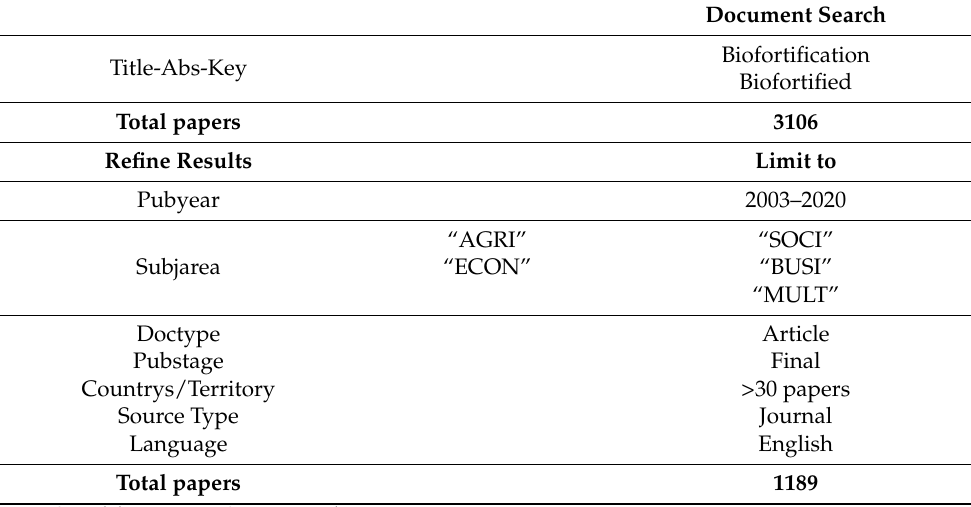
Table 2. Inclusion and exclusion criteria used in the review.